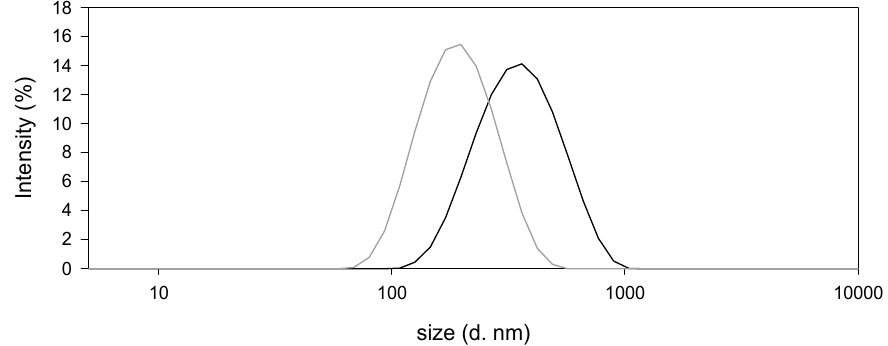
Figure 4. Size distribution by intensity of blank o/w nanocapsules (NCs) (grey) and 1,3-di-m-tolylurea (DMTU)-loaded o/w NCs (black).